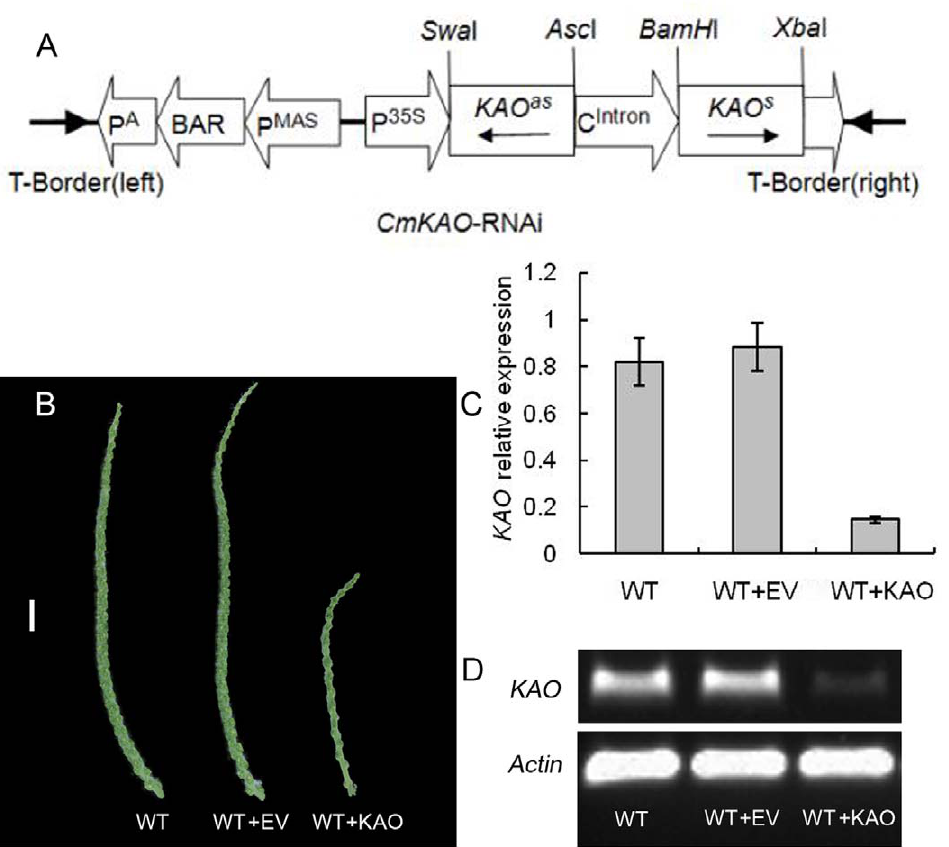
Figure 9. Transient RNA interference of CmKAO in the wild-type catkins. ( A ) Production of the CmKAO -RNAi cassette. ( B ) The phenotypes of WT, WT + EV and WT + KAO in the primordium of the stamen, Bar =1 cm. ( C ) Comparison of relative expression of KAO on WT, WT + EV and WT + KAO. Data are means ( 6 SE, n=3). ( D ) Semi-quantitative RT-PCR analysis for CmKAO transcripts accumulation in WT, WT + EV and WT + KAO.